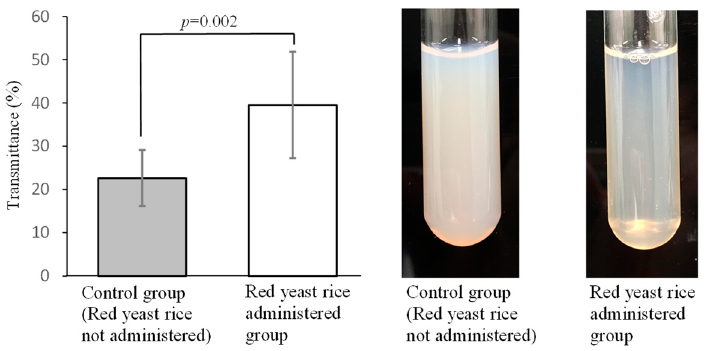
Figure 15. Difference in transmittance of plasma between red yeast rice-treated (2 weeks) and non-treated groups of male Japanese white rabbits (10–12 weeks old) fed a high-cholesterol diet. A decrease in turbidity in the red yeast rice-treated group is apparent. Each bar indicates the mean ± standard deviation. Significant differences were tested by Student's t-test. Plasma cloudiness was evaluated by measuring the transmittance at a wavelength of 660 nm using an absorptiometer.